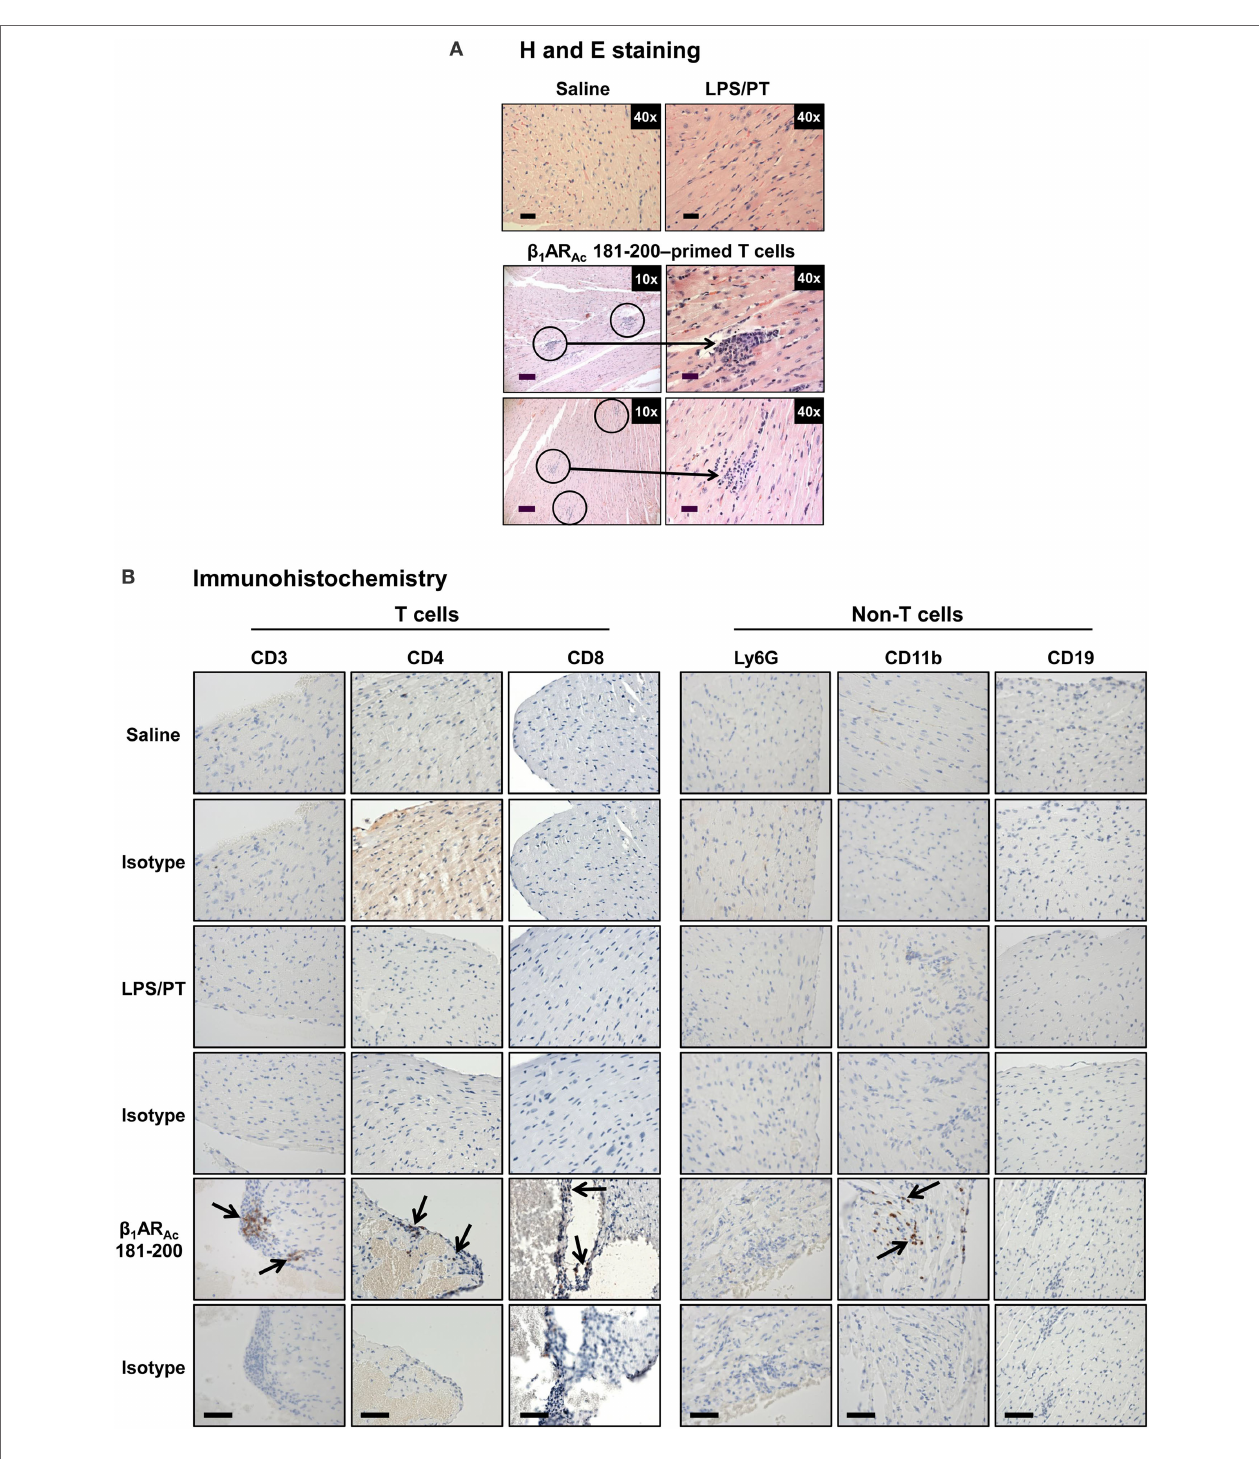
FigUre 6 | Evaluation of hearts for inflammatory changes in naive recipients of T cells sensitized with β 1 AR Ac 181–200. (a) Hematoxylin and eosin (H&E) staining. Groups of mice were immunized with a mixture of β 1 AR Ac 171–190, β 1 AR Ac 181–200, and β 1 AR Ac 211–230 and after 14–21 days, lymph node cells (LNCs) were restimulated with the corresponding peptides for 2 days. After exposing to T helper (Th)1- and Th17-polarizing conditions, cells harvested on day 7 postpolarization and administered into naive mice primed with lipopolysaccharide (LPS). Representative normal heart sections in saline and LPS/PT controls are shown in the top panel. The bottom panel represents recipients of β 1 AR Ac 181–200-sensitized/polarized T cells. Circled areas are shown at higher magnifications to the right in each panel (arrows, inflammatory foci). Scale bar: 120 µm (overview images, 10 × ), 30 µm (magnifications, 40 × ). n = 4 mice per group. (B) Immunohistochemistry. Heart sections were examined for T cells and non-T cells using the antibodies for indicated markers. Detection of cells positive for each marker (arrows) was analyzed by adding HRP-conjugated secondary antibodies as described in the methods section. Representative sections from four animals in each group are shown. Scale bar, 60